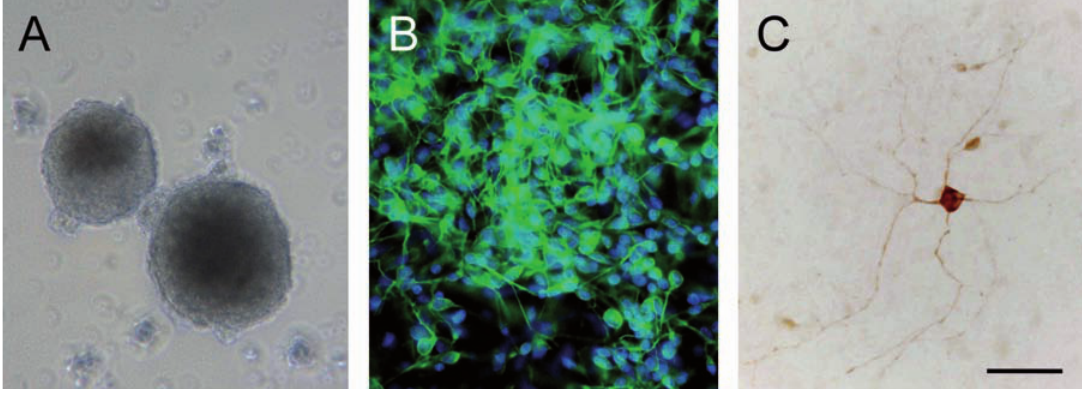
Photomicrographs of rat embryonic subventricular zone stem cells cultured as neurospheres (A). Differentiation of the cultured cells (Hoechst staining, blue) towards the neuronal phenotype is demonstrated by microtubule associated protein 2 immunostaining (green) and neurite outgrowth (B). Further differentiation towards specific neuronal subpopulations, eg, dopaminergic cells, is demonstrated using immunohistochemistry for the catecholaminergic marker tyrosine hydroxylase (C). Scale bar: 200 m m (A), 50 m m